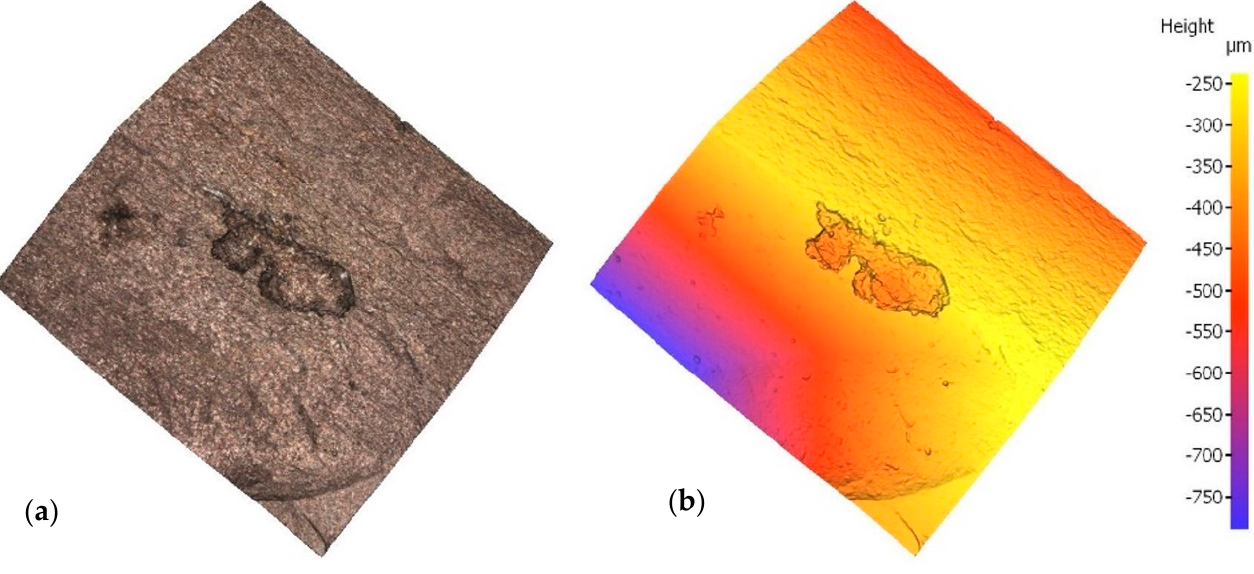
Figure 5. Pit profiles for specimen E12 ( a ) and E21 ( b ) as determined by plotting Py (pit half-width) against Px (pit depth) values.